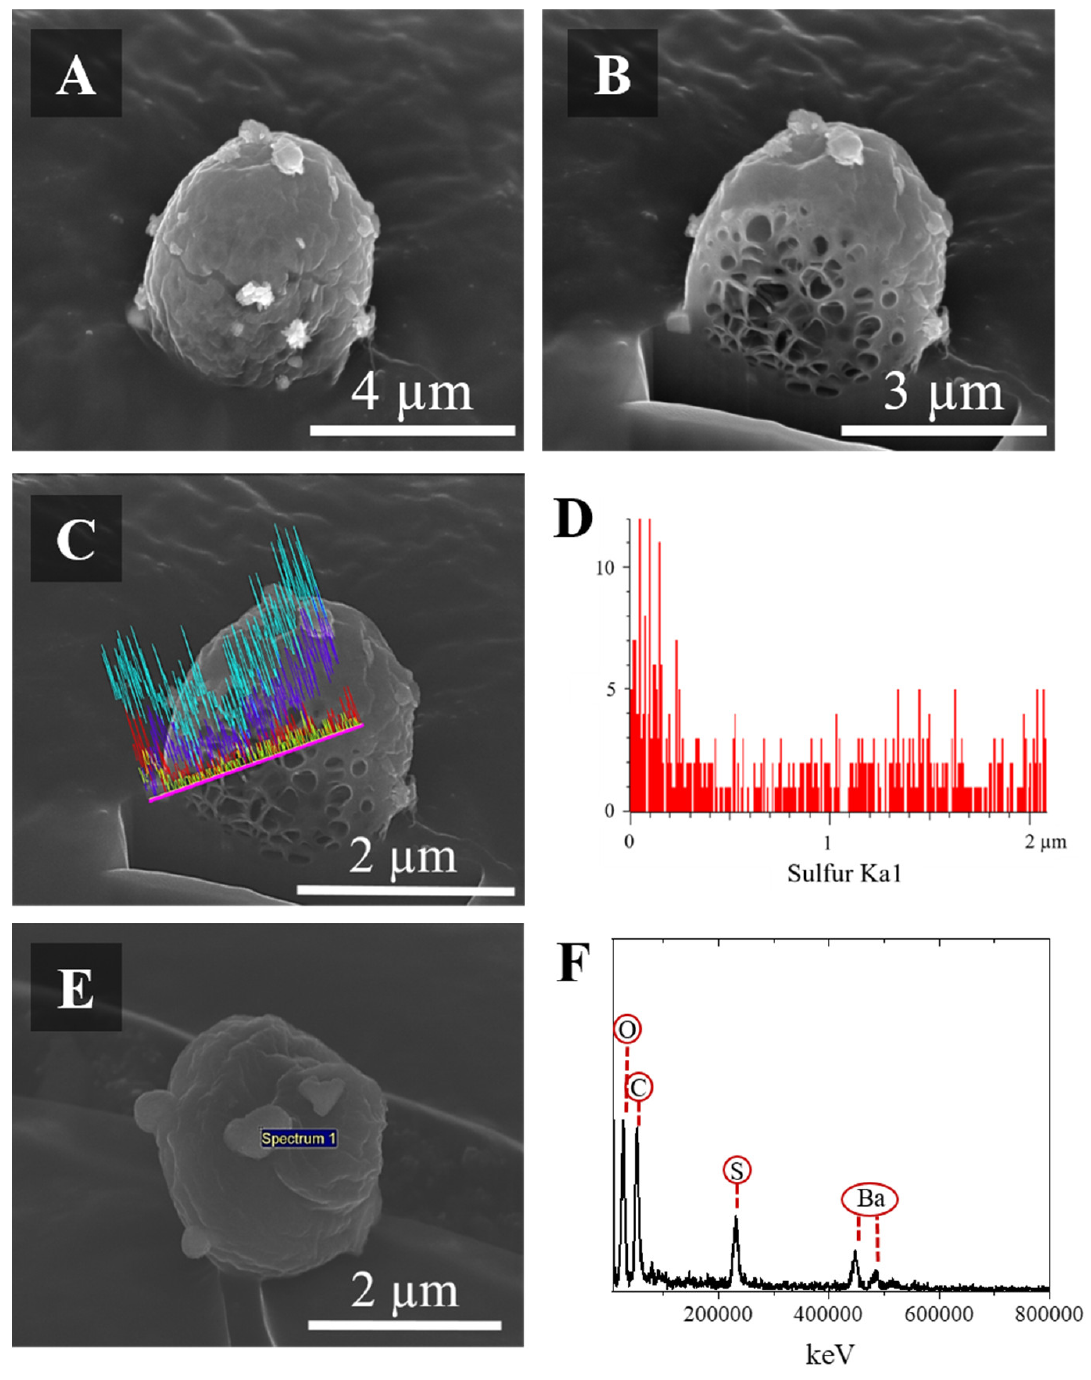
Figure 3. Alginate microparticles with colistin sulfate images from Dual-Beam microscope: ( A , E ) Intact ALG@CLS microparticles; ( B ) View of internal structure of alginate microparticles after cross-sectioning with Dual-Beam; ( C ) Internal analysis of composition along the trajectory marked with a pink line in the figure (colour codes are as follows: Blue = Oxygen, Yellow = Barium, Purple = Nitrogen, Red = Sulfur); ( D ) Detail of Sulfur profile, with a high concentration at the surface of the particle; ( F ) EDX spectrum of a CLS crystal on the surface.